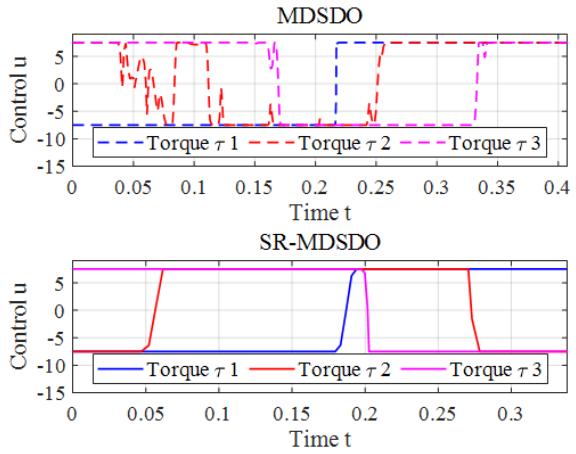
Figure 14. The uncertainty influence on state trajectories under C-MDSDO.